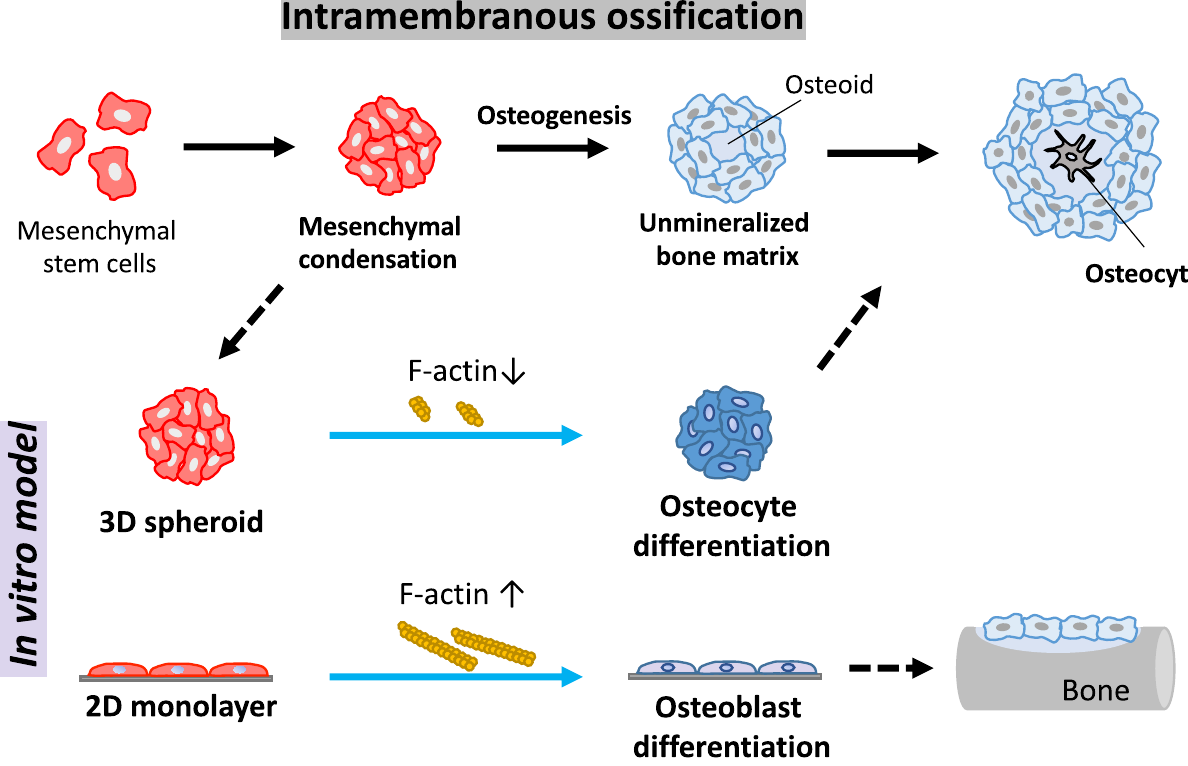
Figure 6. Schematic diagram to highlight the significance of actin depolymerization in the 3D spheroid culture to determine the cell differentiation fate into